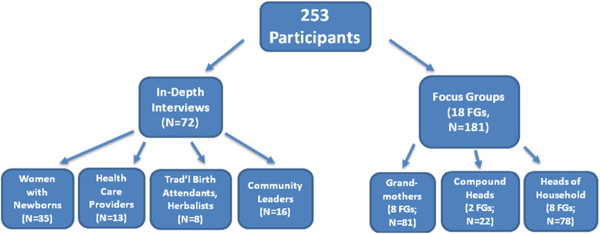
Participants [17].